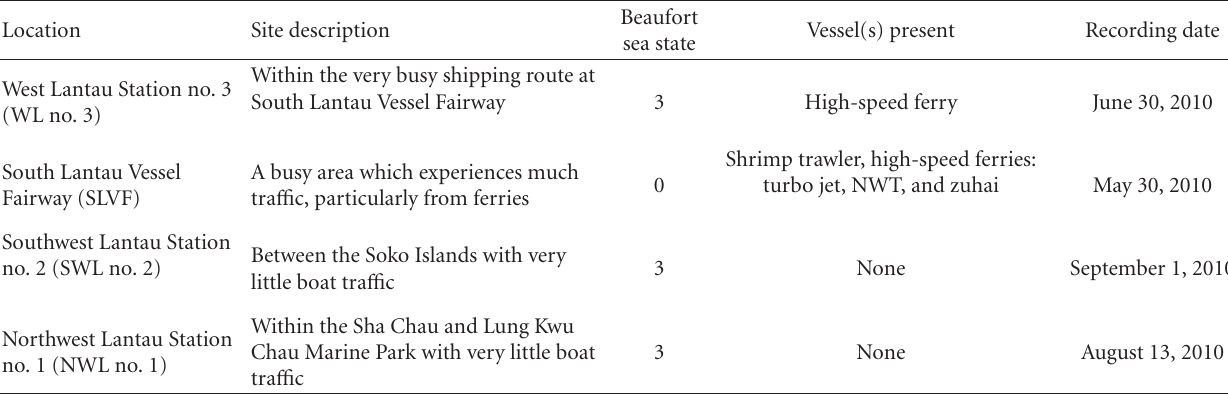
Table 1: Descriptions of ambient noise